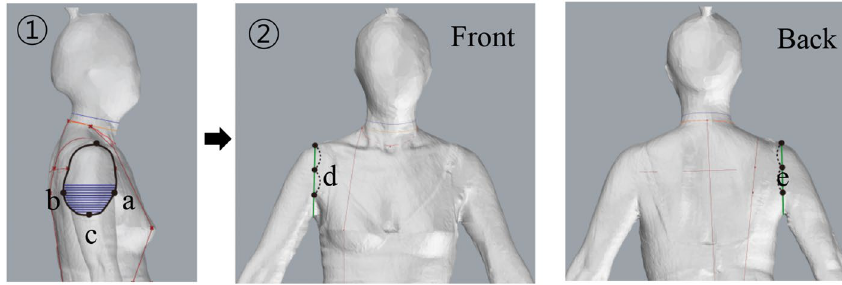
Fig. 7 Front/back axilla point, axilla point, and front/back mid-axilla points search process